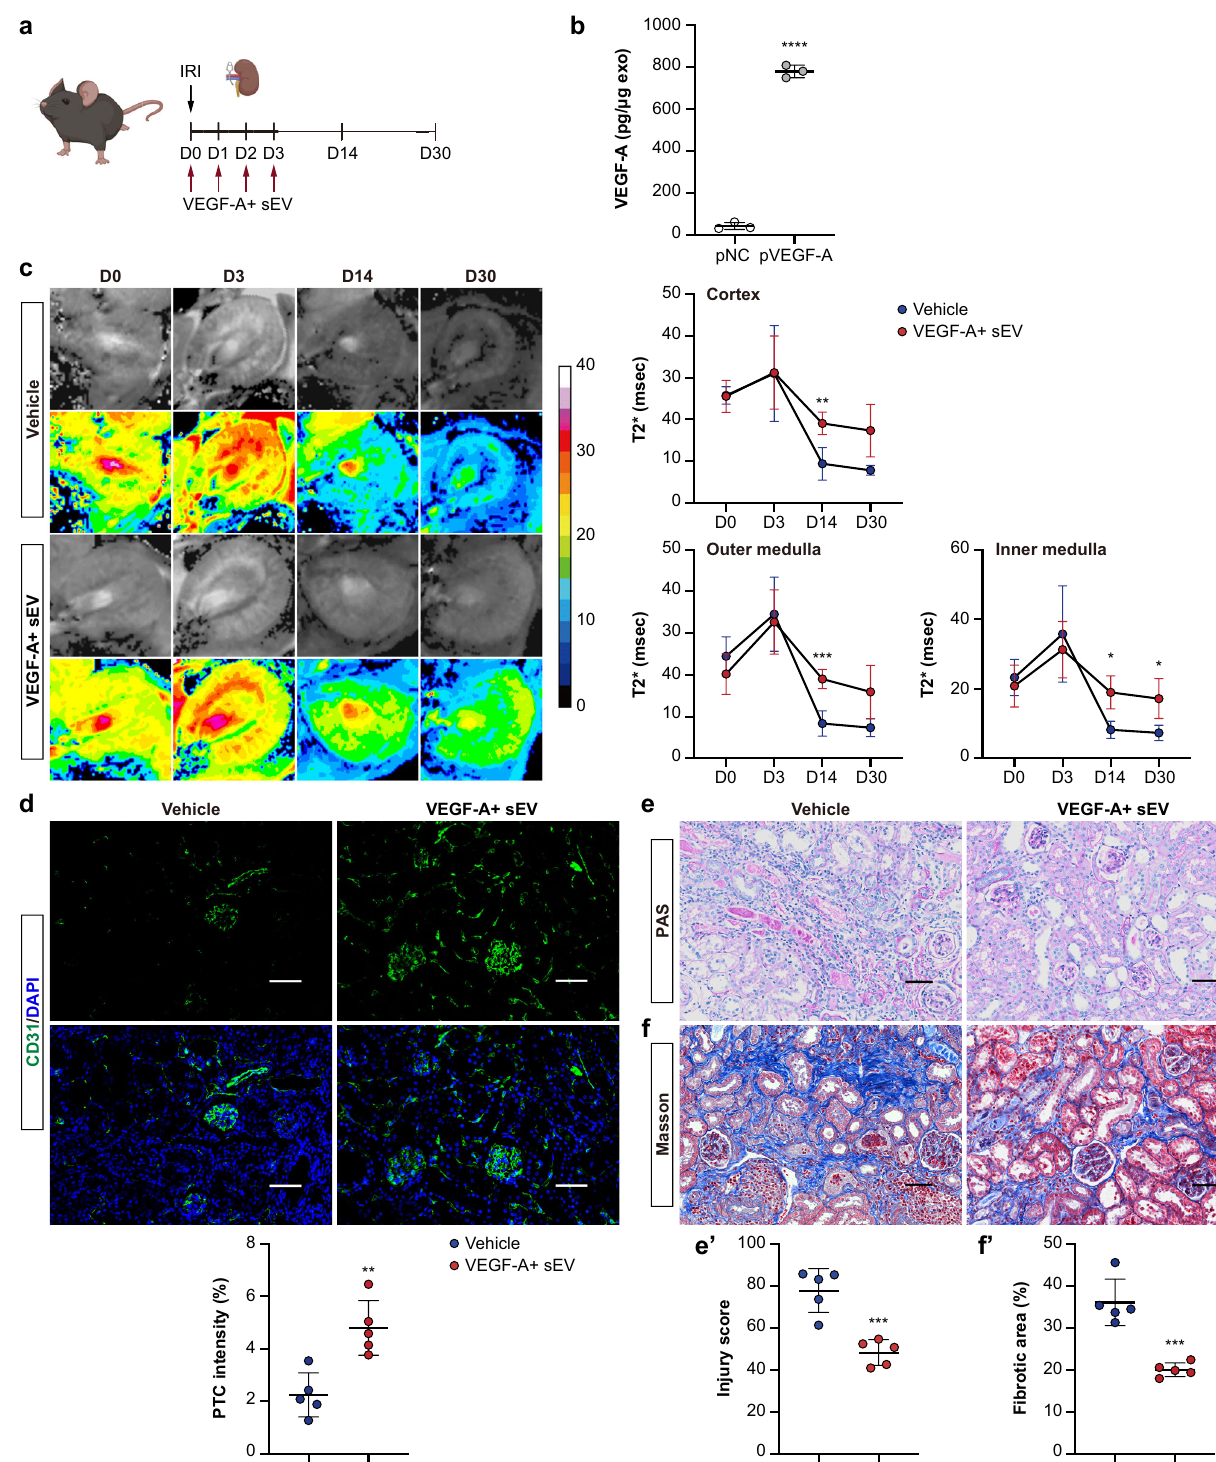
Fig. 6 VEGF-A + sEV treatment attenuates AKI-CKD transition in mice. a Schematic diagram of the experimental design. Brie fl y, mice were subjected to 35 min of unilateral renal IRI, and VEGF-A + sEV (200 μ g) or vehicle was administered upon reperfusion and continued every 12 h for seven times. Mice were euthanized at day 30-post IRI. Schematic created with BioRender.com. b ELISA analysis of VEGF-A concentration in sEV ( n = 3). c Representative images of BOLD-MRI analysis of renal perfusion. Colored scale represents T2* relaxation time (in milliseconds). Quanti fi cation of T2* in renal cortex, outer medulla, and inner medulla ( n = 5). d Representative confocal images of CD31-stained kidney sections. Quanti fi cation on the basis of fi ve mice, with at least ten sections counted in each. e and e ’ Representative images of PAS staining and quanti fi cation of kidney injury. Scale bars, 50 μ m ( n = 5). f and f ’ Representative images of Masson trichrome staining and quanti fi cation of fi brotic area. Scale bars, 50 μ m ( n = 5). Data are presented as means ± SD. * p < 0.05, ** p < 0.01, *** p < 0.001, **** p < 0.0001 vs. pNC ( b ) or Vehicle group ( c , d , e ’ , f ’ ). Two-tailed Student ’ s t